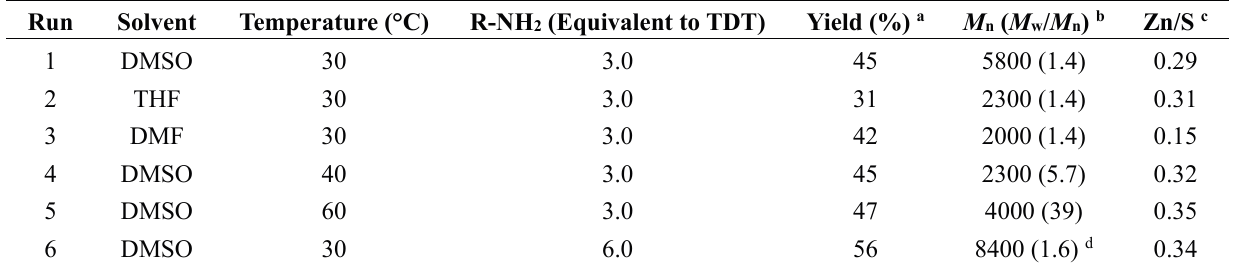
Table 1. One-pot synthesis of organic-sulfur-zinc hybrid via sequential ring-opening addition of EHA and TDT and polycondensation of the in situ generated thiol with Zn(OAc) 2